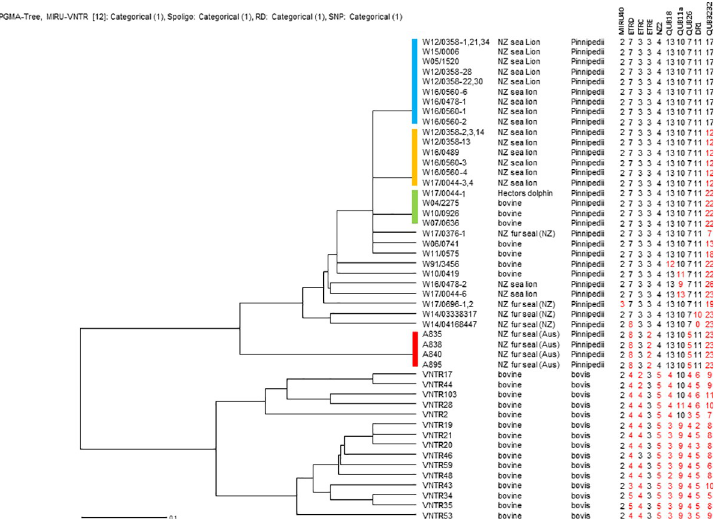
Fig 3. Dendrogram. Nine variable number tandem repeat and two direct repeat loci were used to compare Mycobacterium pinnipedii strains isolated from cattle and pinnipeds in New Zealand with selected M . pinnipedii isolates from Australian pinnipeds and selected M . bovis isolates from New Zealand cattle.